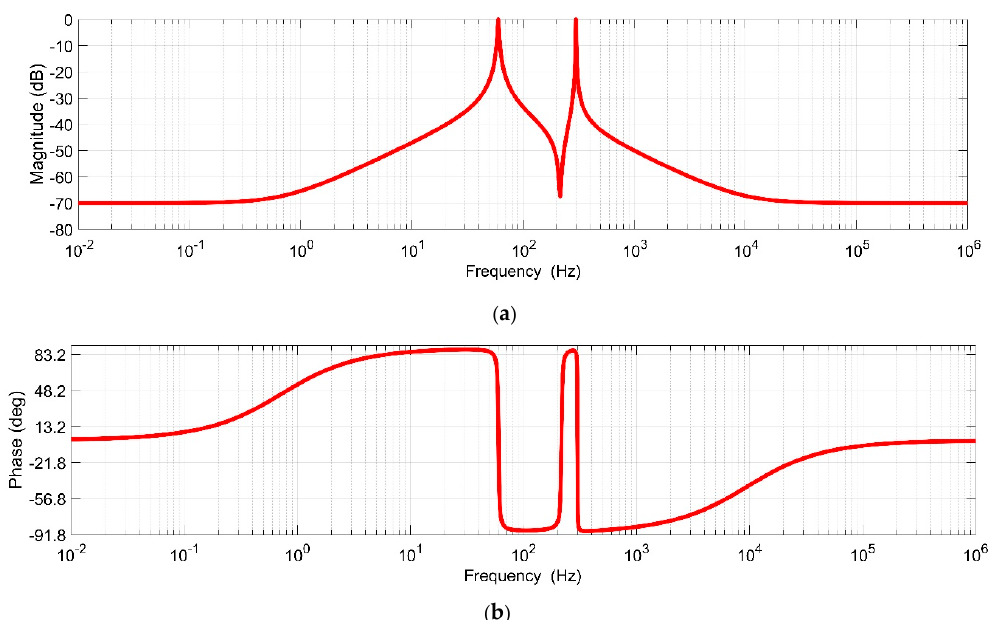
Figure 15. ( a ) Magnitude response, ( b ) phase response of designed combined resonant paths.